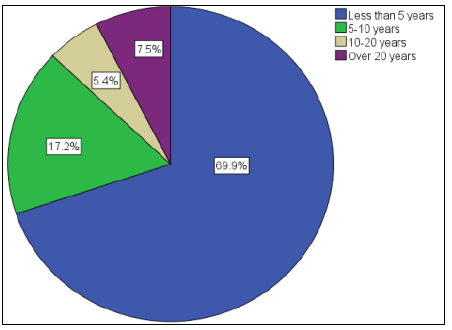
Figure 2: Length of Time Respondents have worked in Food Service; Source: Author